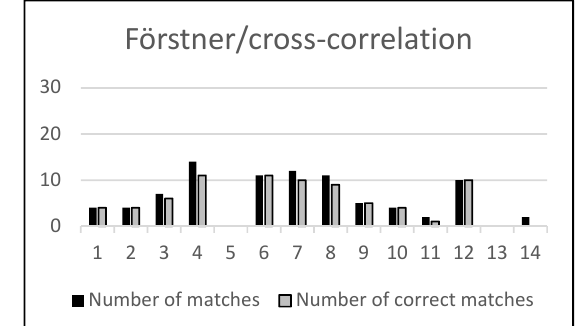
Figure 3. Matching results of proposed method across all 14 tiles